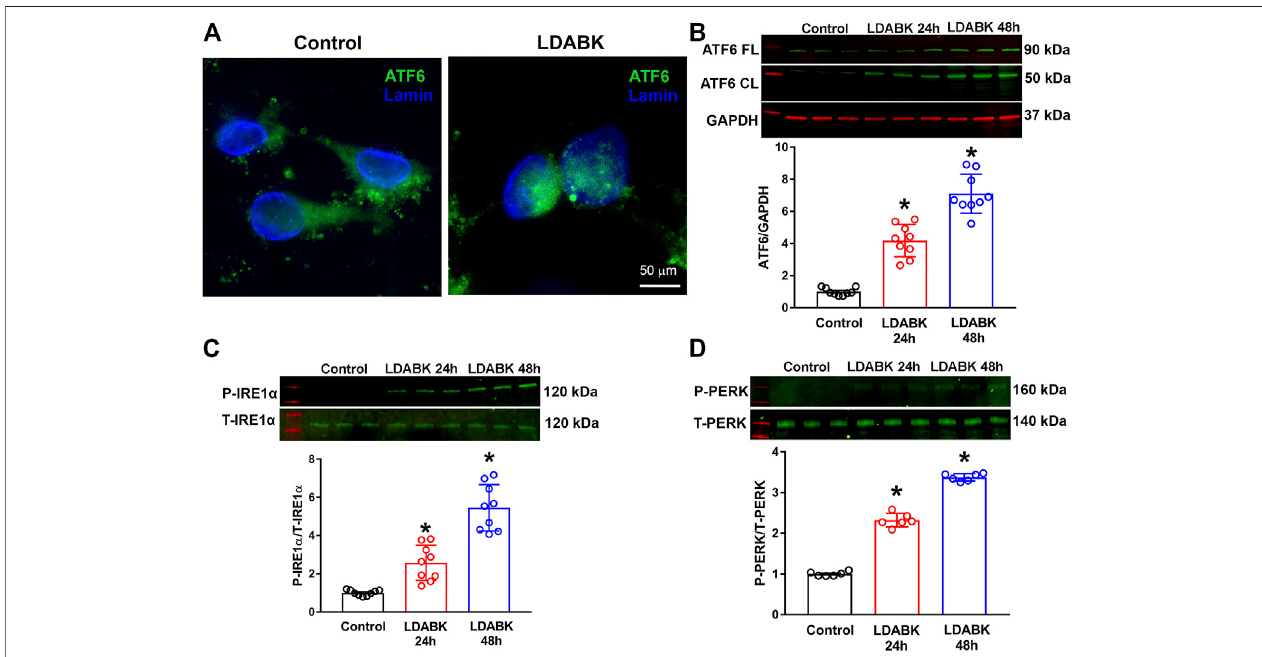
FIGURE2| B1RstimulationinducestheactivationofERstresssensorsinprimaryhypothalamicneurons.PrimaryhypothalamicneuronswerestimulatedwithB1R speci fi cagonistLDABK(300 nM)orvehicle(phosphatebufferedsaline)for24or48 handtheactivationofERstresssensorsdeterminedusingimmuno fl uorescenceand westernblotanalysis. (A) Immuno fl uorescencestainingrevealedthatATF6undergoesnucleartranslocationinneuronsaftertreatmentwithB1RagonistLDABKfor24 h. (B) Quantitativewesternblotanalysisshowsanincreaseintheactivated cleavedformofATF6byLDABKstimulation.FL:Fulllength,CL:Cleaved. (C) Westernblot analysis illustrates an increase in the phosphorylation of IRE1 α and (D) PERK, following LDABK treatment in primary hypothalamic neurons. * p < 0.05, compared to control. ( n = 6 – 9/group).